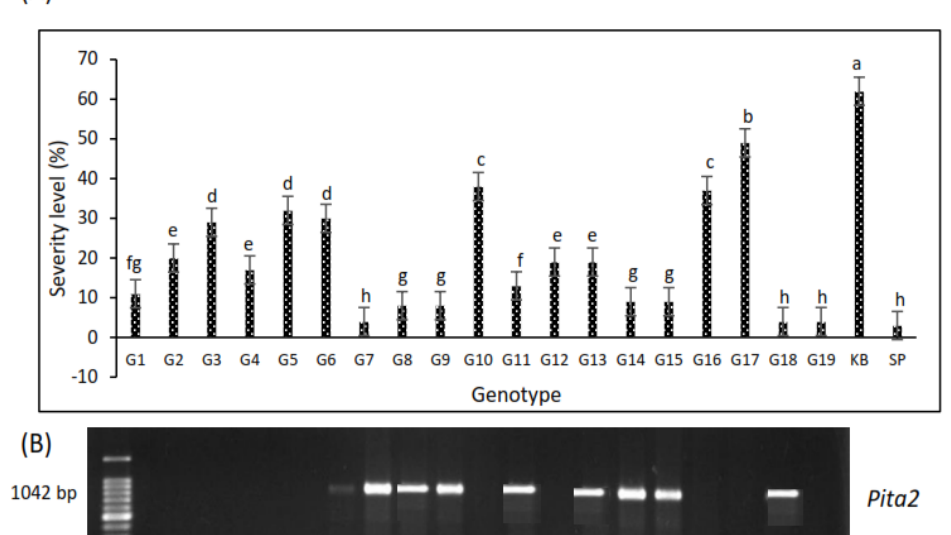
Figure 9. ( A ) The severity level of blast disease in the field in 19 genotypes, with Kencana Bali as a sensitive and Situ Patenggang as a resistant control. Different letters indicate statistically significant differences at p = 0.05 by LSD test; ( B ) the expression of the Pita2 gene in the G7, G8, G9, G11, G13, G14, G15, and G18 lines amplified at 1042 bp showed the consistency of blast resistance in the field.